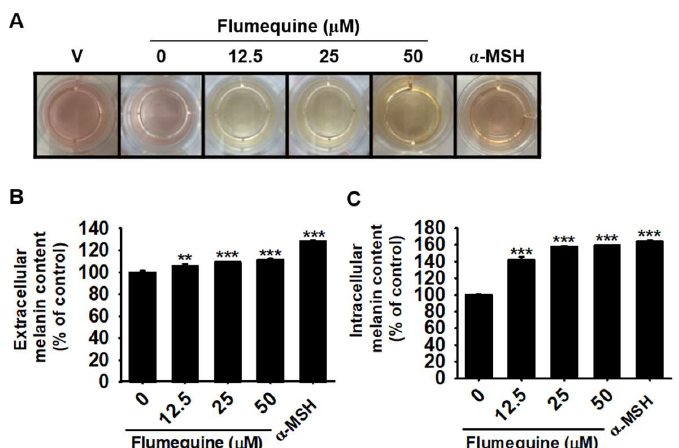
Figure 3. Flumequine increases the extracellular and intracellular melanin production in B16F10 cells. B16F10 cells were exposed to flumequine (0–50 µ M) for 72 h. ( A ) Images of the culture medium color were captured. Extracellular ( B ) and intracellular ( C ) melanin content was measured at 72 h. The percentage values in each group are relative to those in the untreated control. The results are